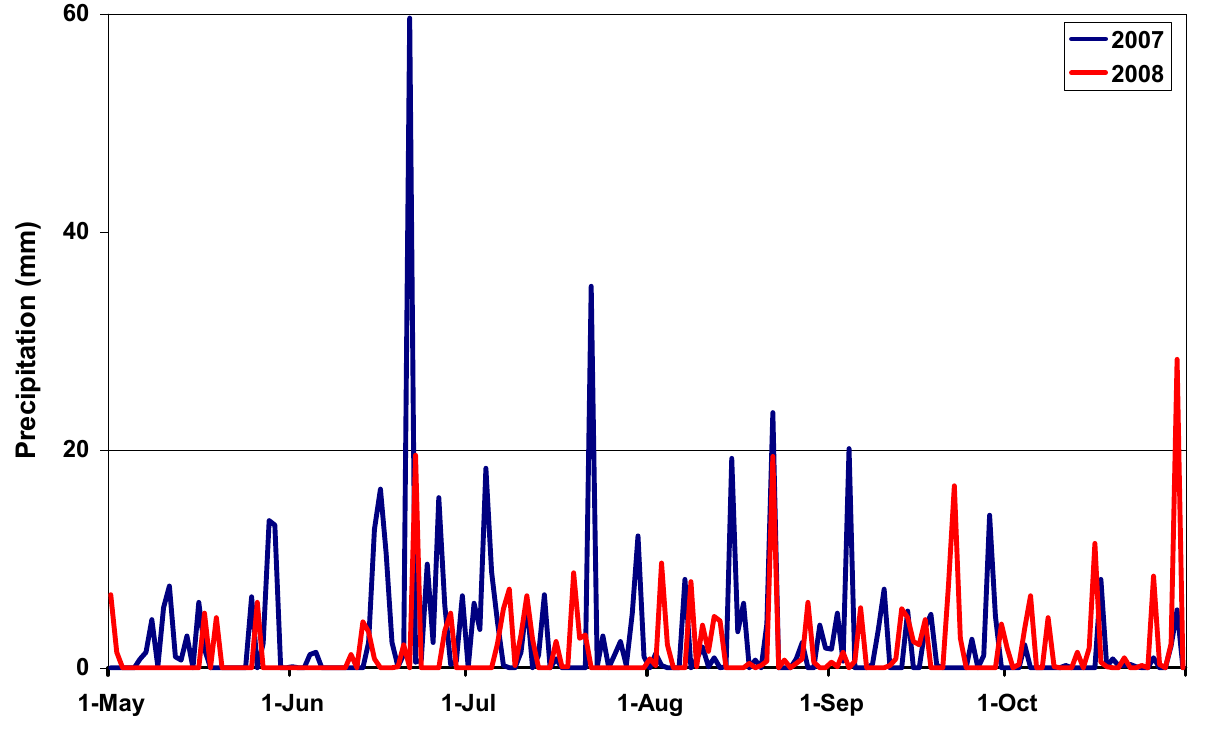
Figure 3. Daily precipitation data from a nearby weather station (Greifswald) during sampling period (May–October of 2007 and